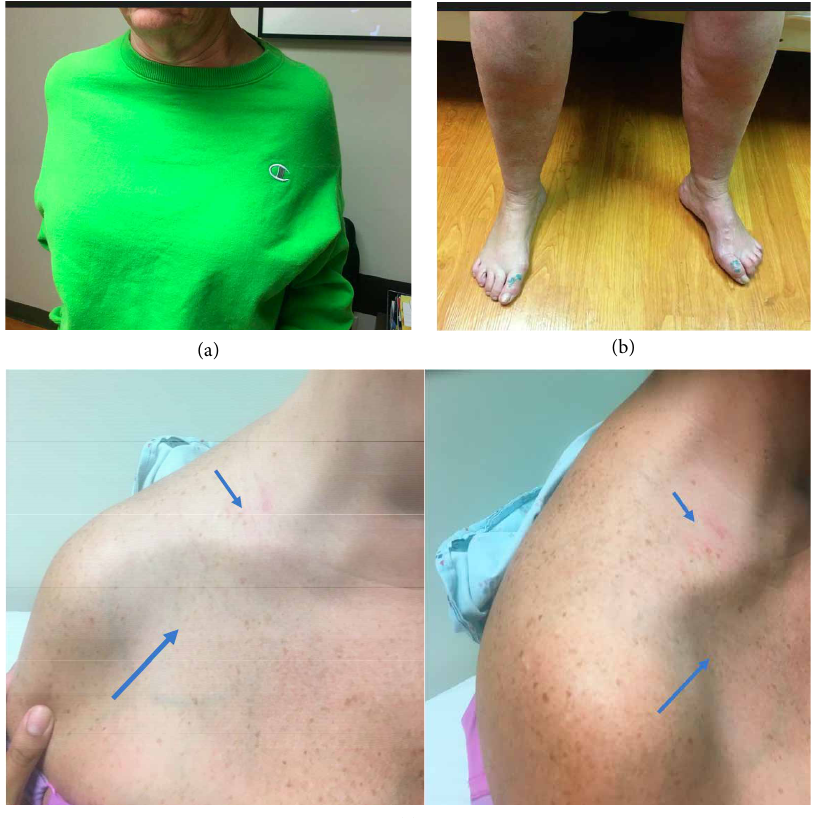
Figure 1: Slanted shoulders seen in the proband (a); asymmetric pes cavus in left foot (b); and trapezius and pectoralis atrophy seen in the proband (arrows)